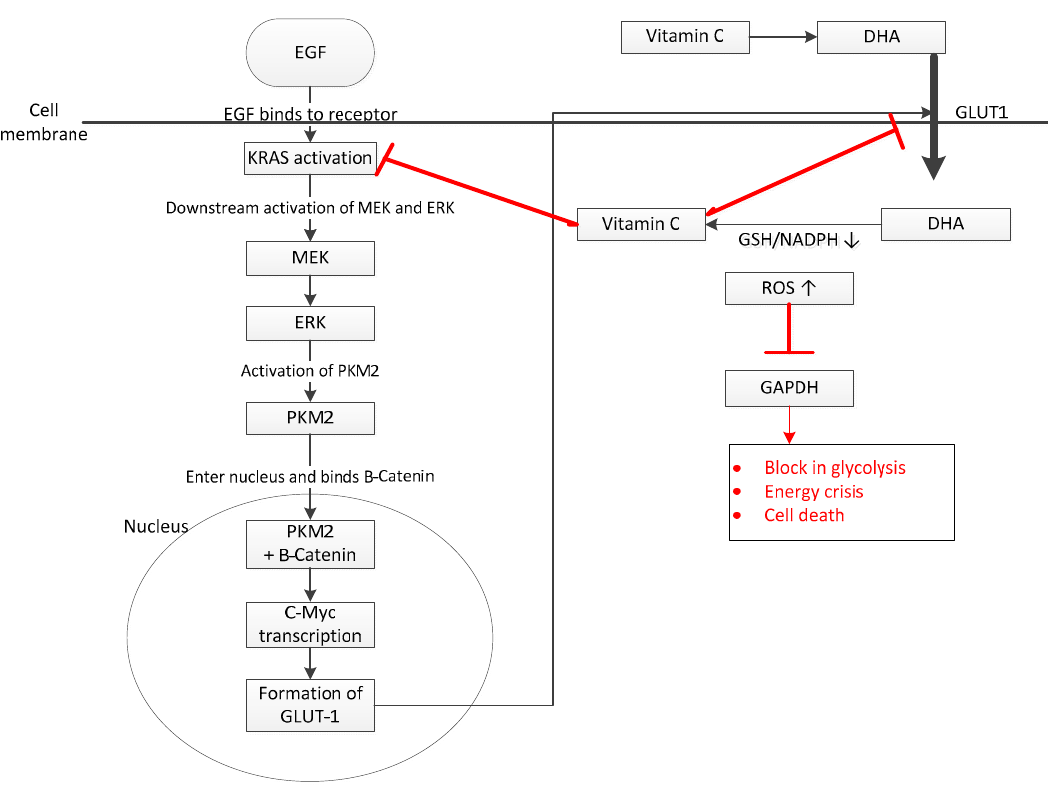
Figure 1. Effect of ascorbic acid (AA) on KRAS mutant colon cells. Upon entry into the cell, dehydroascorbate (DHA) is reduced to AA which has two effects: ( 1 ) RAS detachment from the cell membrane which inhibits the downstream phosphorylation cascade (MEK/ERK/PKM2) which, in turn, inhibits GLUT-1 expression; and ( 2 ) glutathione depletion during the reduction process leads to accumulation of reactive oxygen species (ROS), which leads to the inactivation of GAPDH. These two effects inhibit glycolysis in cells that are highly dependent on energy, leading to an energy crisis and cell death. The effect of vitamin C is denoted in red.